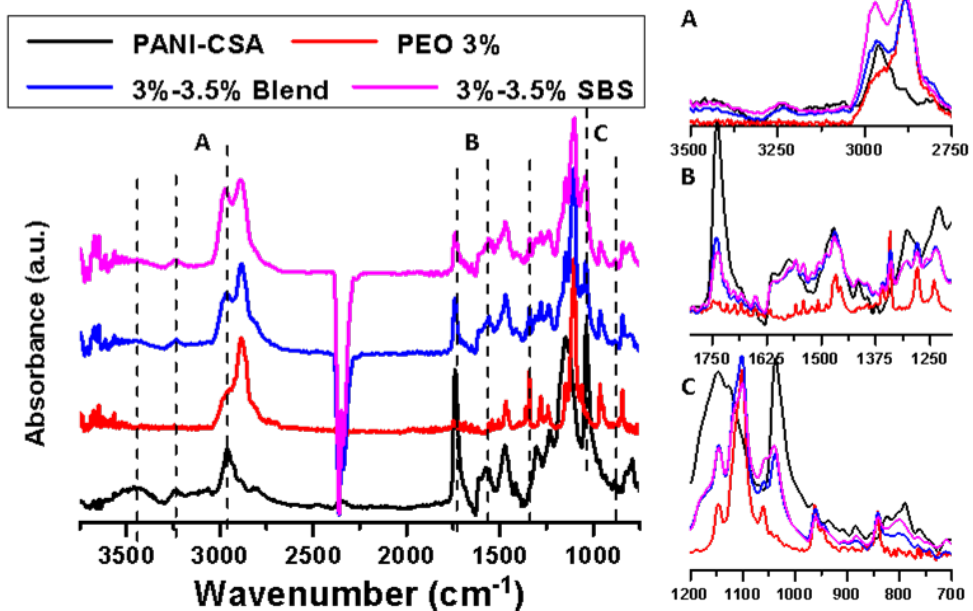
Figure 7. Fourier-transform infrared spectroscopy (FTIR) curves of PANI-CSA, neat PEO, PEO-PANI (3%–3.5%) blend and side-by-side fibers. The inserts ( A , B , C ) were enlarged images of three corresponding regions with the same baseline.